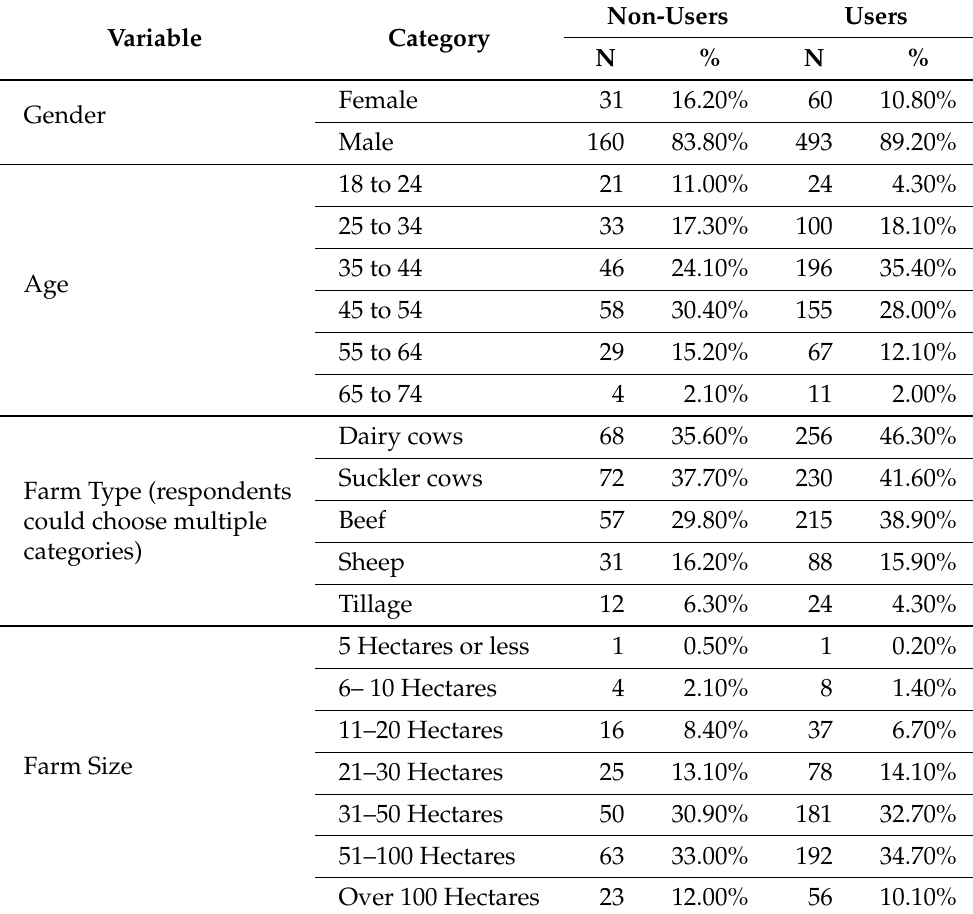
Table 1. Sample characteristics for both